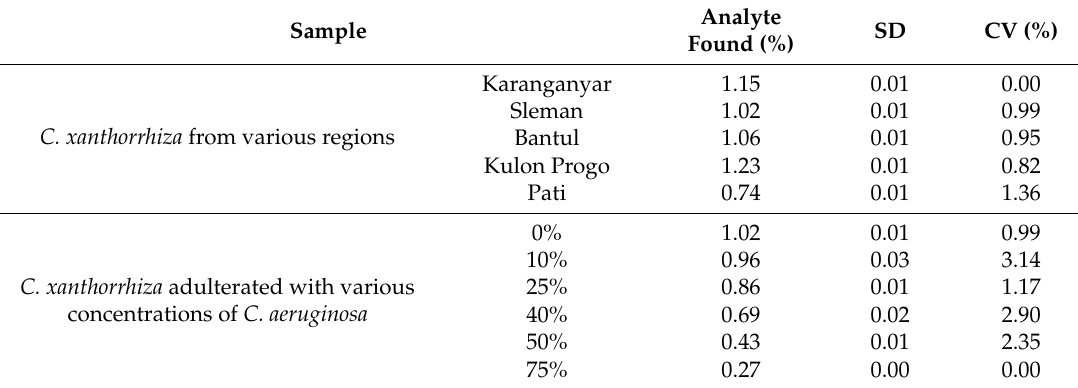
Table 2. Results of curcumin analysis of the